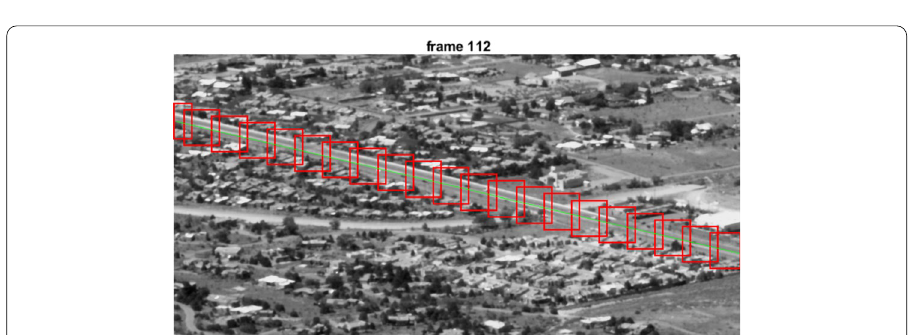
Fig. 4 Constraint processing illustration (processing region is denoted by red box, road path is denoted by green